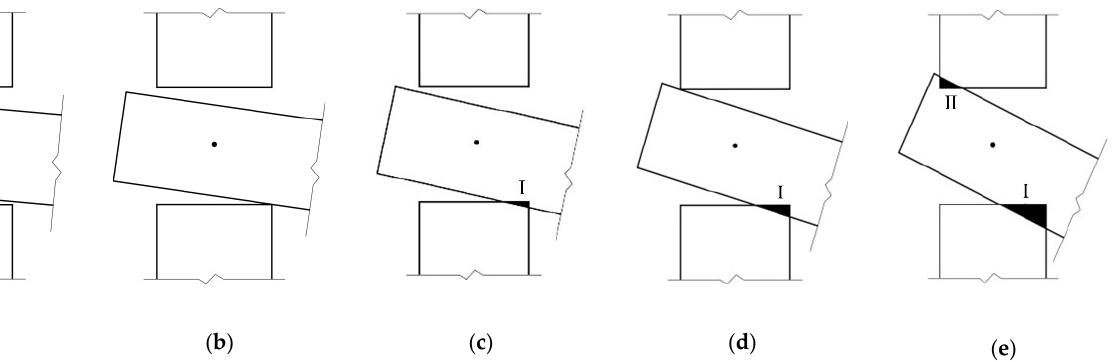
Figure 6. Working states under positive loading: ( a ) free rotation; ( b ) critical state I; ( c ) compression state I; ( d ) critical state II; ( e ) compression state II.